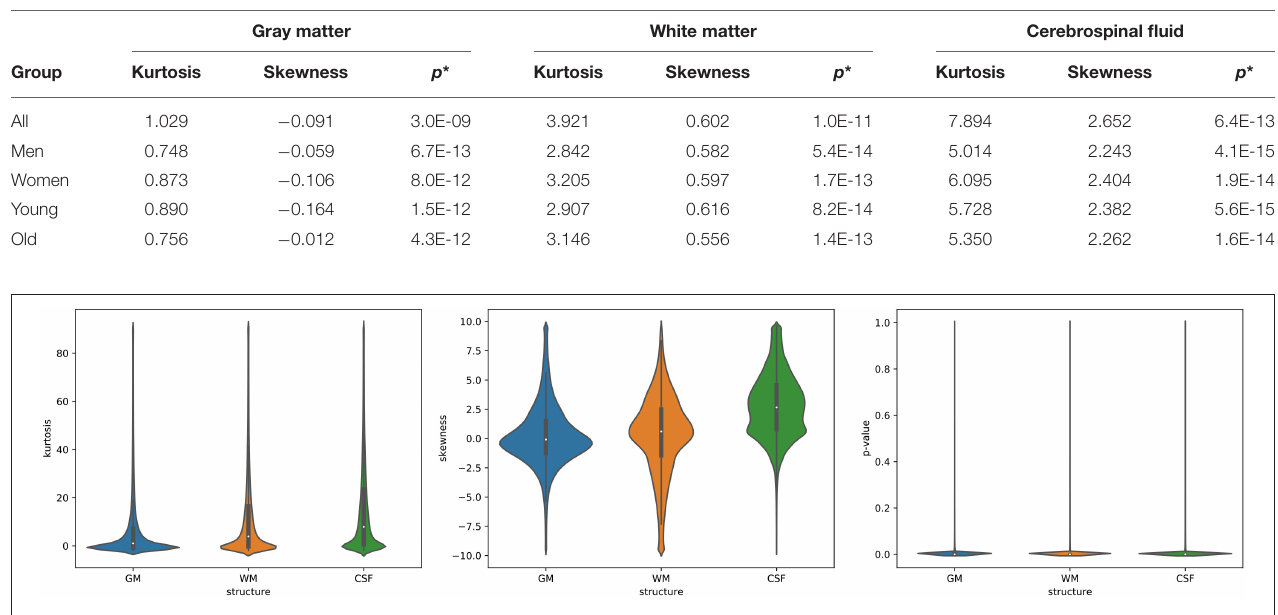
FIGURE 7 | The violin plots of the data distribution ( left : kurtosis, middle : skewness, right : Shapiro-Wilk test p -values) across the entire brain (GM, WM, and